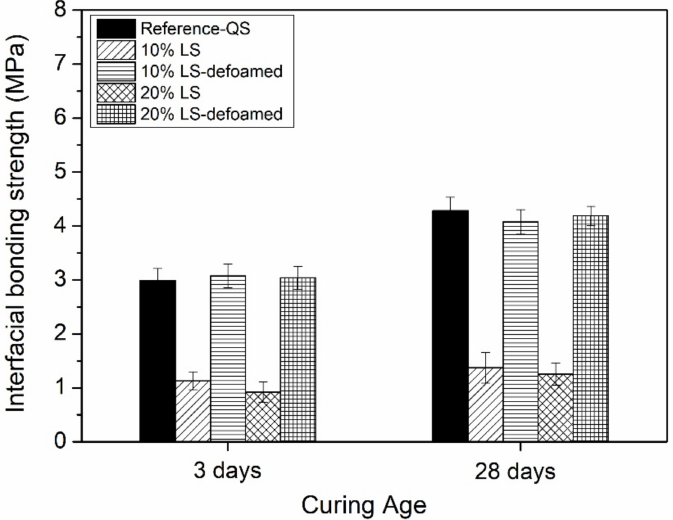
Figure 9. Interfacial bonding strength (at curing age of 3 days, 28 days) of MAPC mortar samples containing limestone fines (at content of 10% and 20%) with or without defoaming treatment by the compound use of 0.3% polyether modified silicone (PMS) defoamer and 1% Portland cement